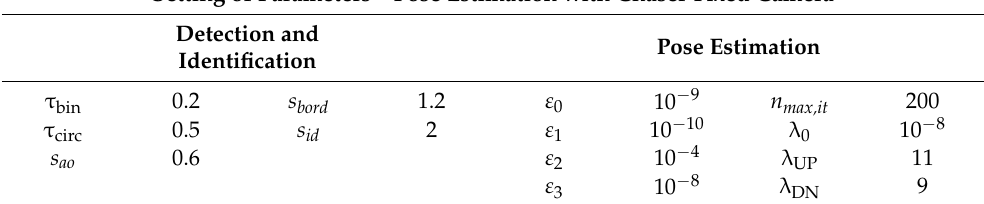
Table 11. Summary of the setting parameters employed for the pose estimation algorithms with both the chaser-fixed and eye-in-hand